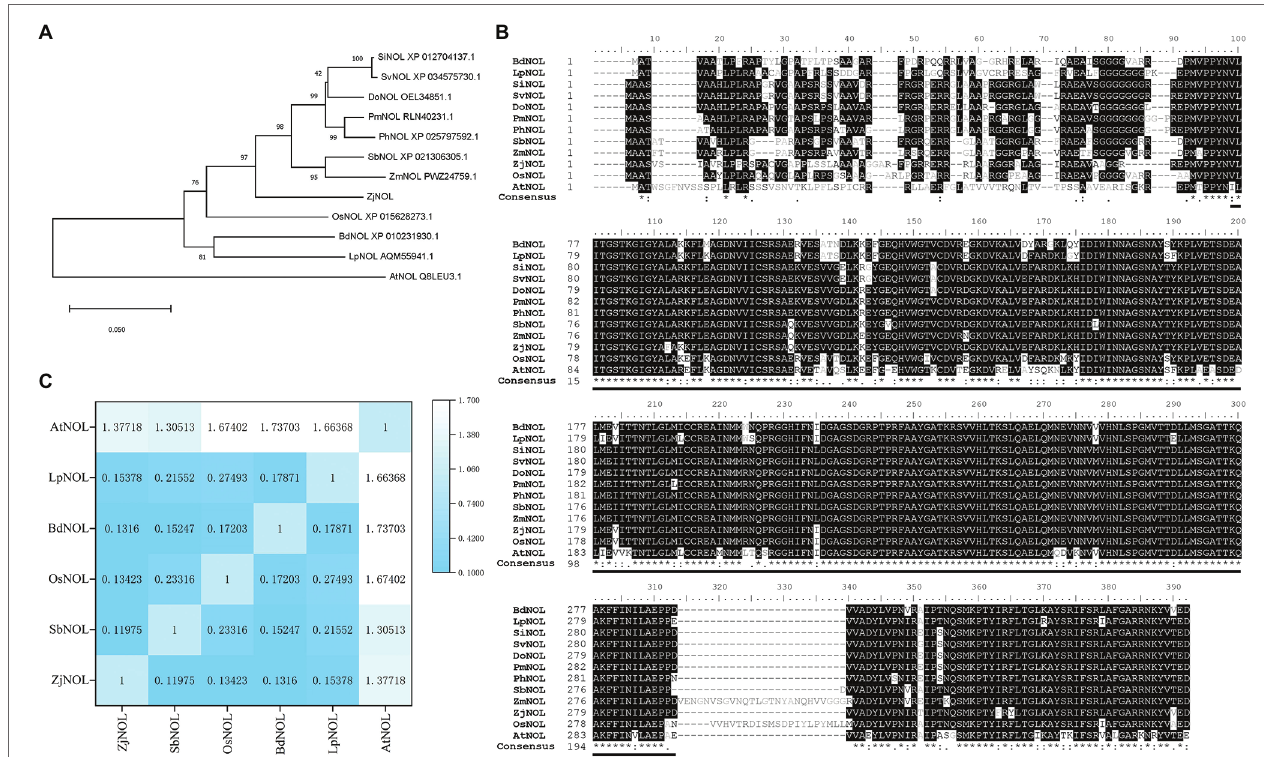
FIGURE 1 | Bioinformatic analysis of ZjNOL . (A) Phylogenetic tree. The neighbor-joining tree was constructed using MEGA 11, orthologous proteins in Setaria italica (SiNOL), Setaria viridis (SvNOL), Dichanthelium oligosanthes (DoNOL), Panicum miliaceum (PmNOL), Panicum hallii (PhNOL), Sorghum bicolor (SbNOL), Zea mays (ZmNOL), Zoysia japonica (ZjNOL), O ryza sativa (OsNOL), Brachypodium distachyon (BdNOL), Lolium perenne (LpNOL), and Arabidopsis thaliana (AtNOL) were used for analysis. (B) Multiple sequences alignment and conserved domain prediction. (C) Calculation of the Ka/Ks.